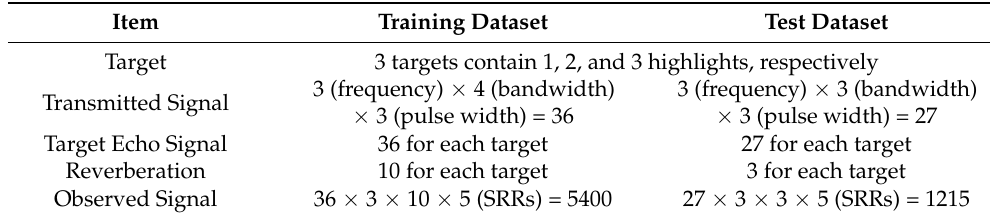
Table 2. Configuration for simulated dataset.